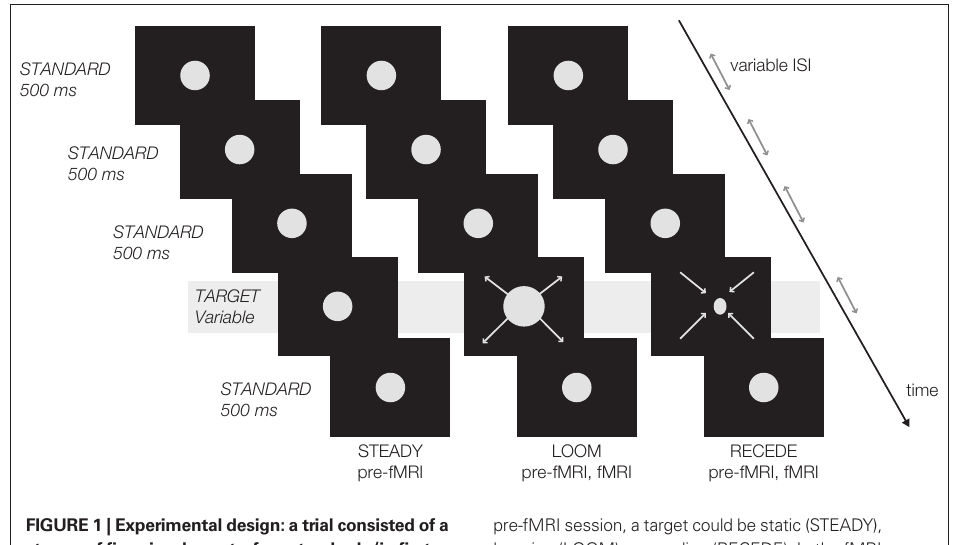
FIguRe 1 | experimental design: a trial consisted of a stream of five visual events, four standards (in first, second, third and fifth position) and one target (fourth position). All standards were static discs of ∼ 500 ms duration (STANDARD); all targets were presented in fourth position in the sequence and varied in duration. In the